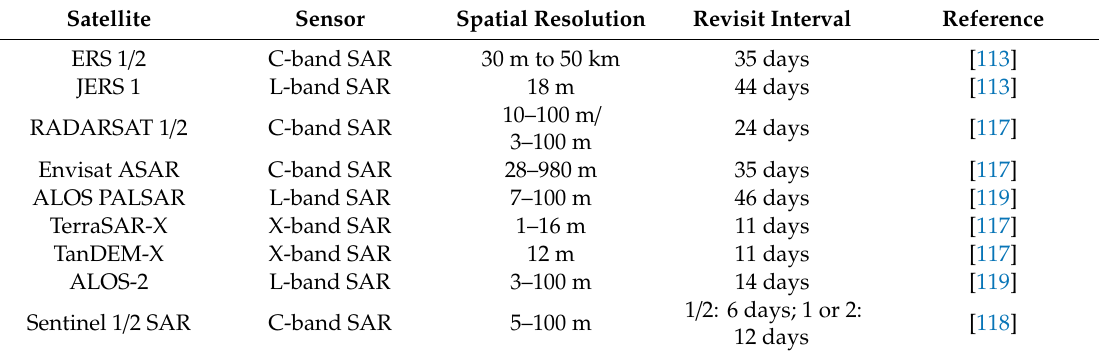
Table A2. Widely used radar satellite RS